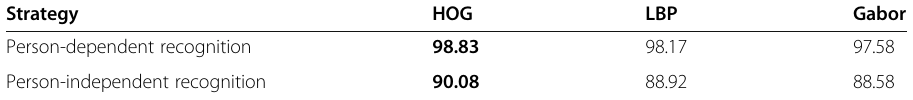
Table 4 Accuracy (%) for pose-variant non-frontal facial expression recognition